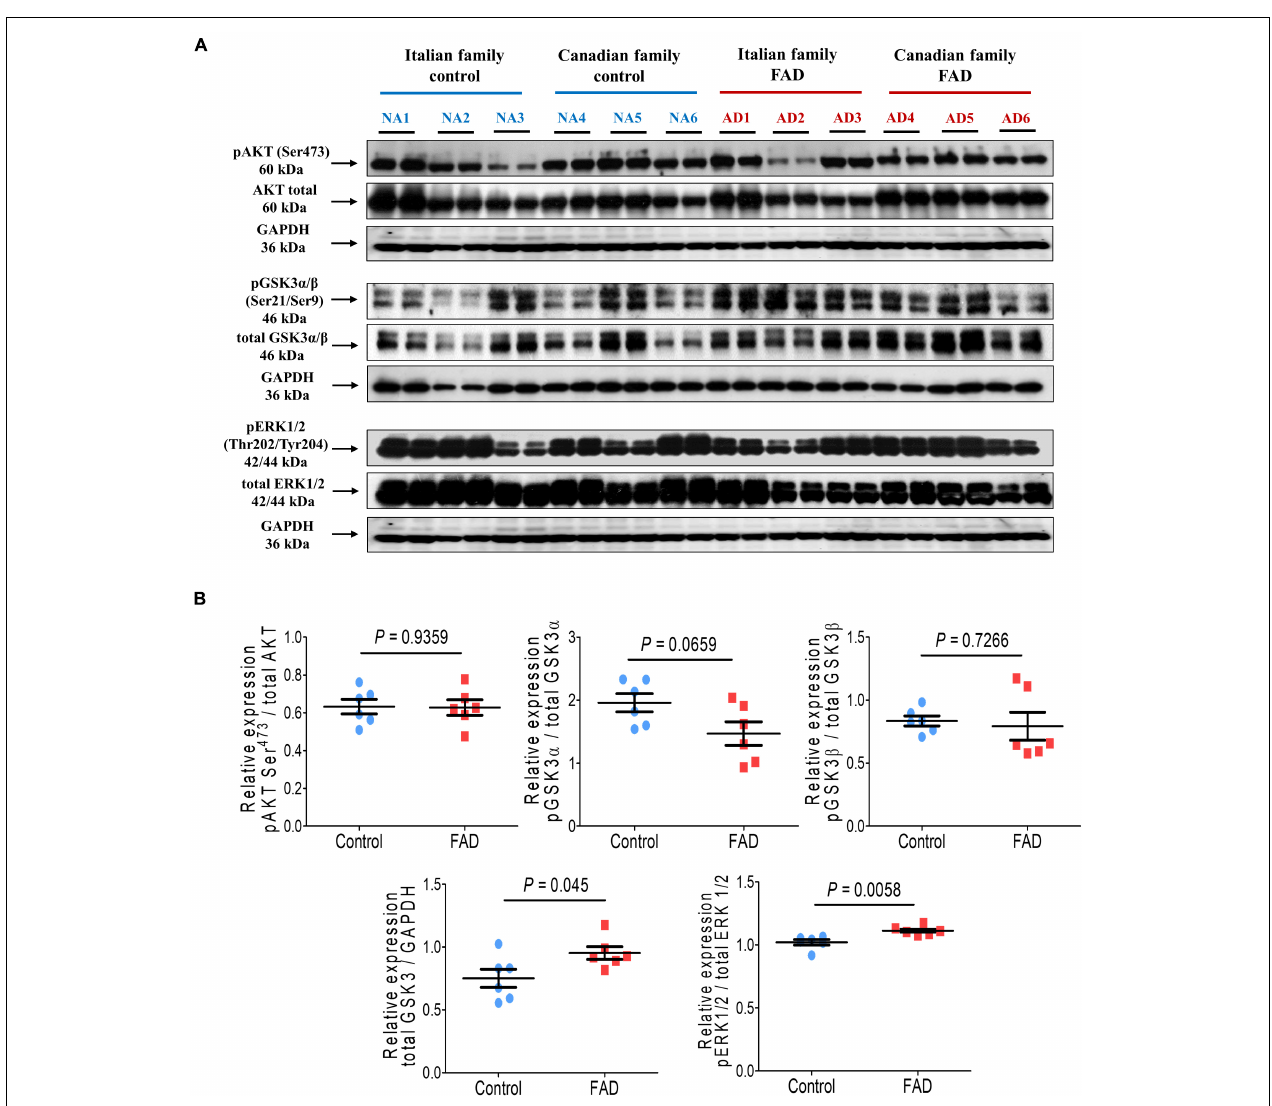
FIGURE 3 | Immunodetection of cell survival markers (pAKT Ser 473 ), phosphorylation of kinases involved in hyperphosphorylation of the tau protein (GSK3 α Ser 21 , GSK3 β Ser 9 , and ERK1/2 Thr 202 /Tyr 204 ) in fibroblasts from FAD individuals and control subjects (NA). Proteins were evaluated by Western blotting. (A) Blots for fibroblast protein extracts from control (6) and FAD (6) individuals. Samples were analyzed in duplicate. (B) Analysis of pAKT Ser 473 , GSK3 α Ser 21 , GSK3 β Ser 9 , total GSK3 and ERK1/2 Thr 202 /Tyr 204 . Protein phosphorylation levels were normalized to their total protein content and total GSK3 was normalized against GAPDH. The points on the graphs represent the average value of duplicates for each sample. Statistical analysis in (B) was performed with Student’s t